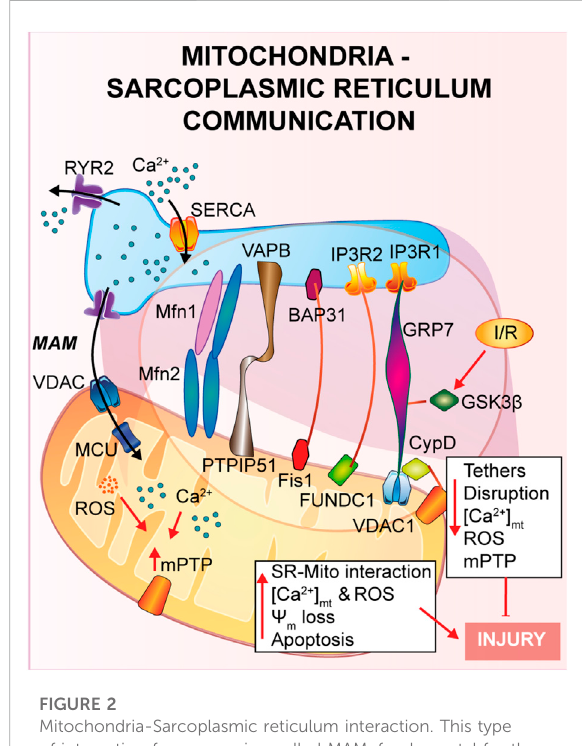
FIGURE 2 Mitochondria-Sarcoplasmic reticulum interaction. This type of interaction forms a region called MAM, fundamental for the presenceofseveralproteinsthatguaranteeacorrecttetheringand regulate Ca 2+ cycle. In general, a reduction in the SR- mitochondria tethering correlates with decrease in mitochondrial Ca 2+ uptake, reduction of cell death and cardioprotection to